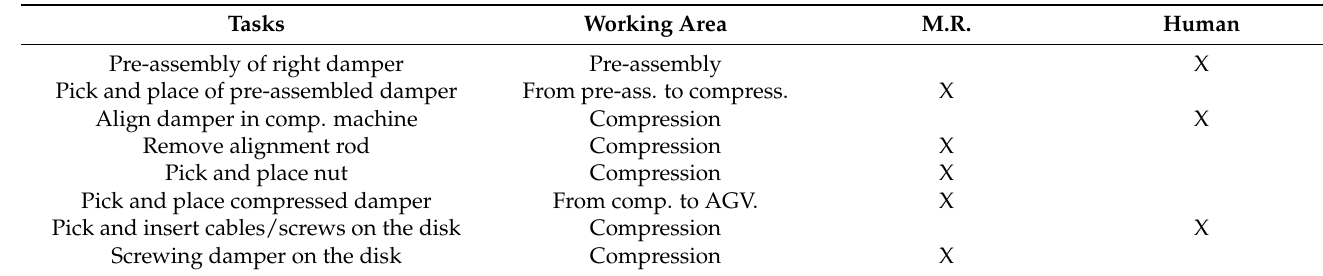
Table 1. Assembly tasks allocation to resources.